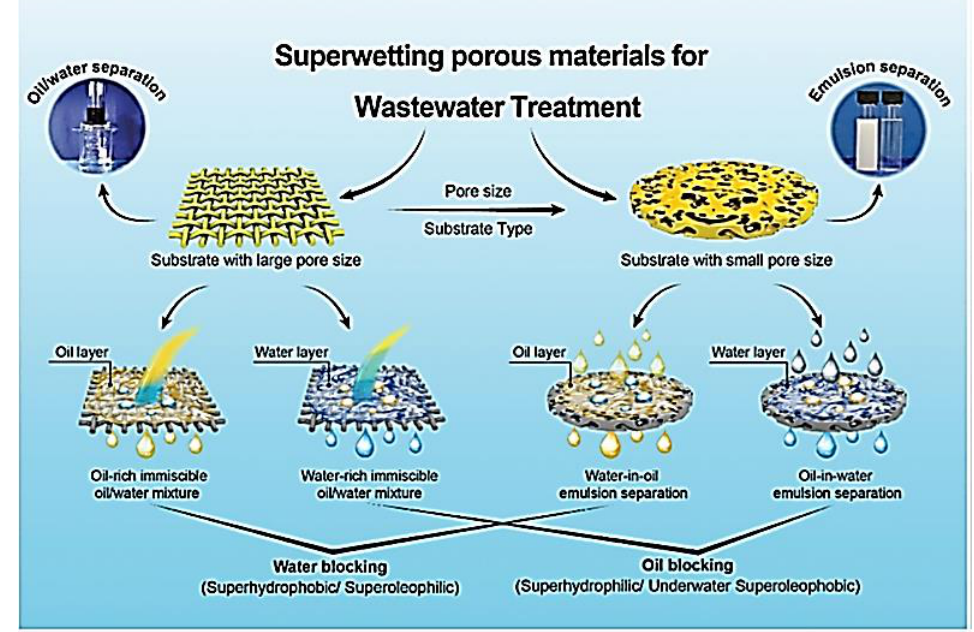
Figure 3. Design of the superwetting porous materials and the mechanism of oil/water separation or emulsion separation [100]. Reprinted with permission from Ref. [100] Copyright © 2017 WILEY-VCH Verlag GmbH & Co. KGaA, Weinheim, Germany.